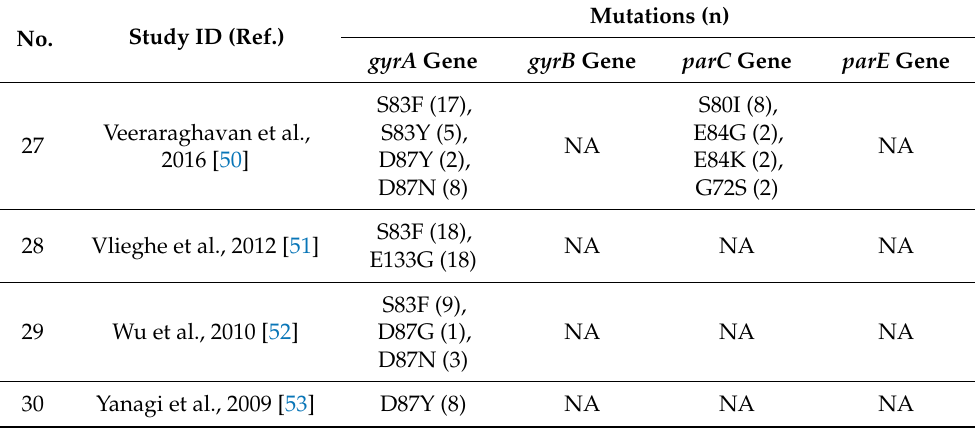
Mutations (n) S80I (8), E84G (2), NA NA E84K (2), G72S (2) NA NA NA NA NA NA